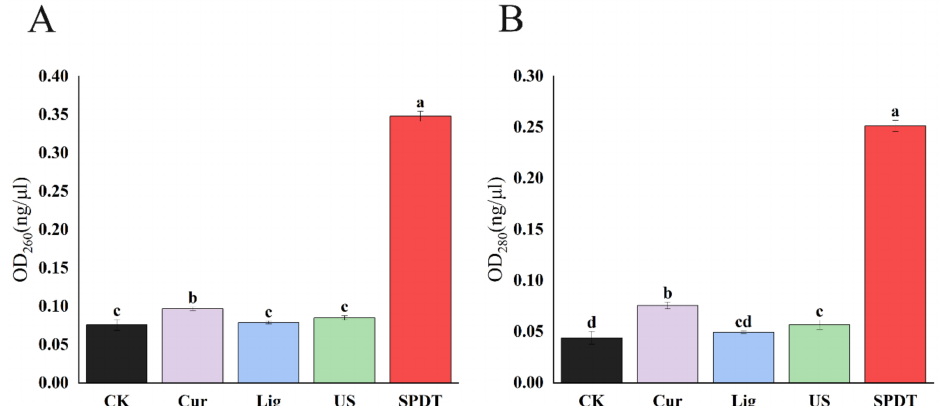
Figure 5. Release of 260 nm ( A ) and 280 nm ( B ) absorbing cytoplasmic materials from Listeria monocy- togenes. CK: Control group without treatment; Cur: Curcumin-treated group; Lig: Light-illuminated group; US: Ultrasound-treated group; SPDT: Curcumin-mediated sono-photodynamic treated group. Different lowercase letters above the columns indicate the significant difference ( p < 0.05).